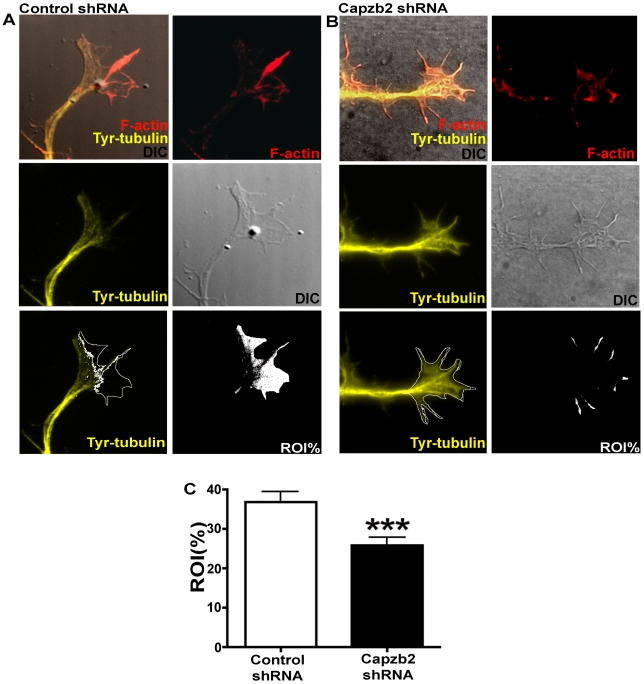
Comparison of growth cone area not invaded by microtubules in neurons transfected with either control shRNA/pEGFP or Capzb2 shRNA/pEGFP.(A and B) Visualization of microtubules in the growth cones was obtained with tyrosinated α-tubulin antibody signal (Tyr-tubulin, yellow); F-actin (red) upon CytD treatment. The percentage of growth cone area not invaded by microtubules (ROI%, white area) was obtained upon subtraction of Tyr-tubulin signal from the total growth cone area visualized on DIC image. The image left of the panels labeled ROI% shows the ROI border (white line overlay on Tyr-tubulin signal image) composed of the line indicating microtubule most distal position (based on Tyr-tubulin signal) and the outline of the growth cone (based on DIC image). (C) The average ROI% was significantly lower in neurons transfected with Capzb2 shRNA (n = 63, blinded analysis from three experiments) in comparison to controls (n = 85, blinded analysis from three experiments). Mean values ±s.e.m. are depicted; *** = p<0.001.